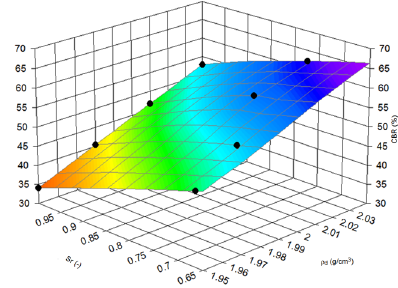
Figure 7. 3D view of CBR value dependence from density and saturation ratio, fraction 2–25